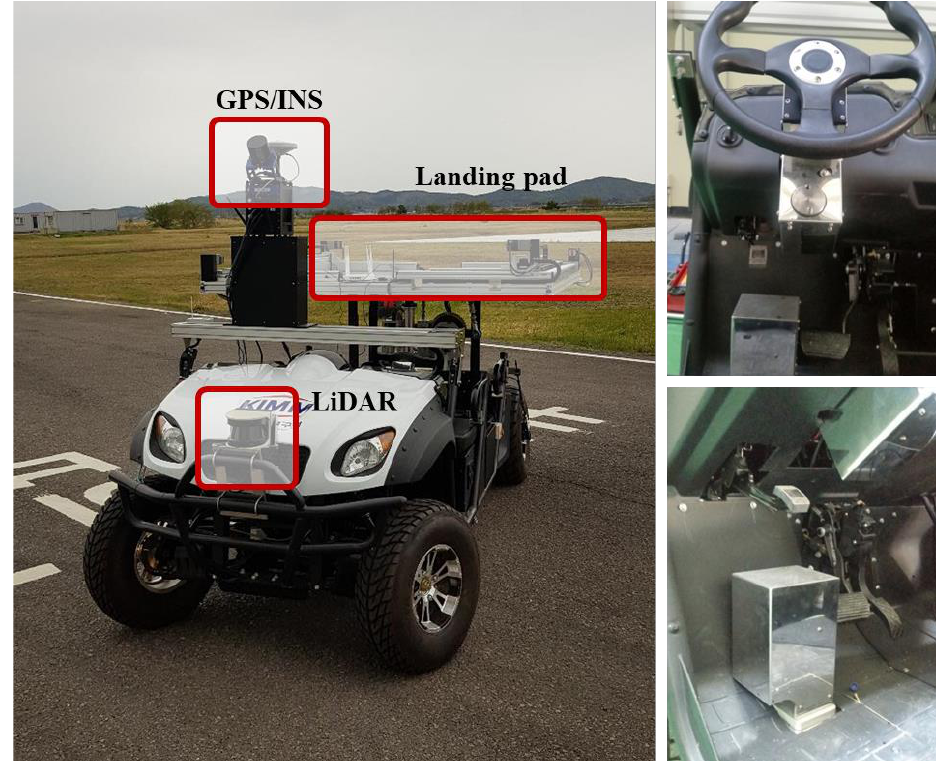
Figure 1. UGV for cooperative mission.